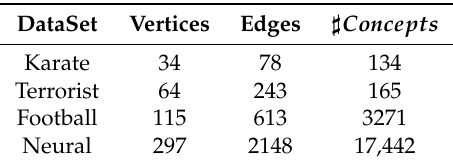
Table 2. Statistics of